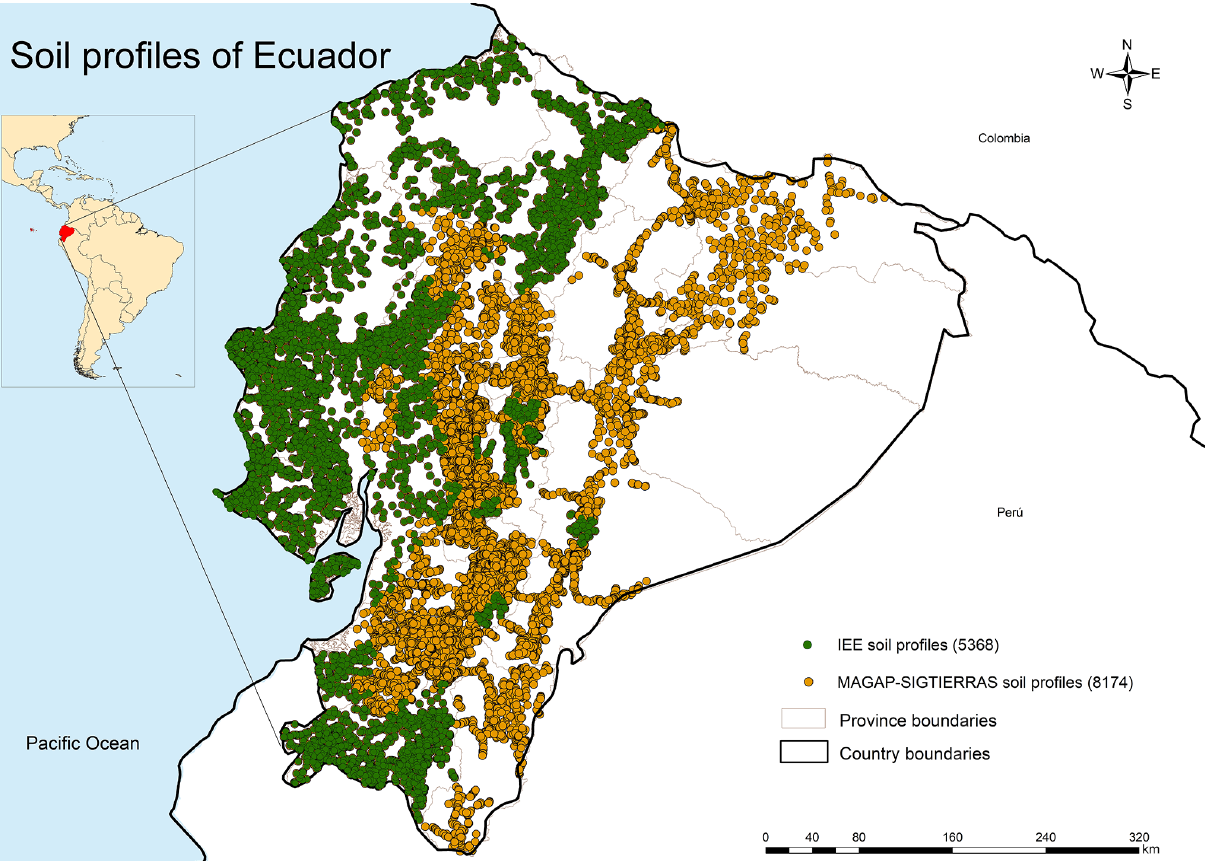
Figure 1. Spatial distribution of soil profiles in Ecuador compiled in the HESD.